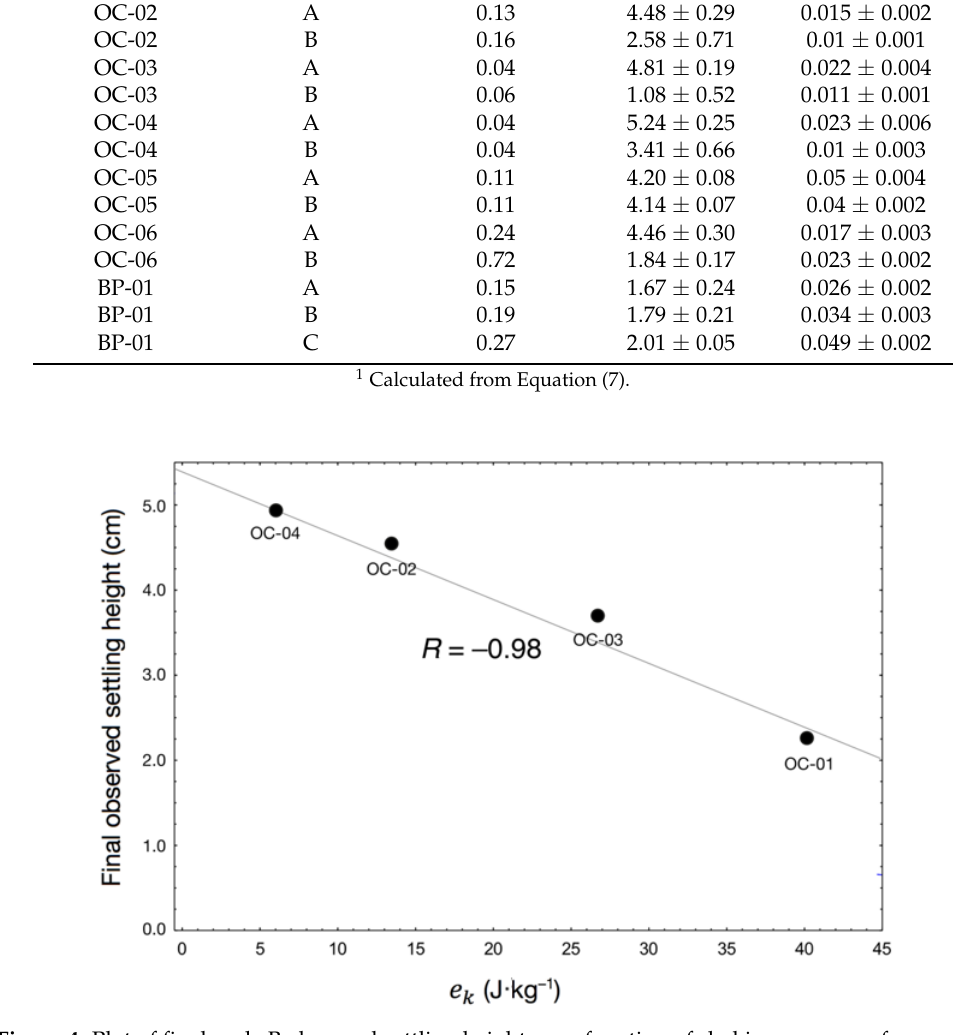
Figure 4. Plot of final cycle B observed settling heights as a function of shaking energy e k for samples OC-01, -02, -03, and -04 (for which 6.0 ≥ e k ≥ 40.2 J · kg –1 ). The best fit line (grey) accounts for 98% of the variance in the data points ( R = –0.98).